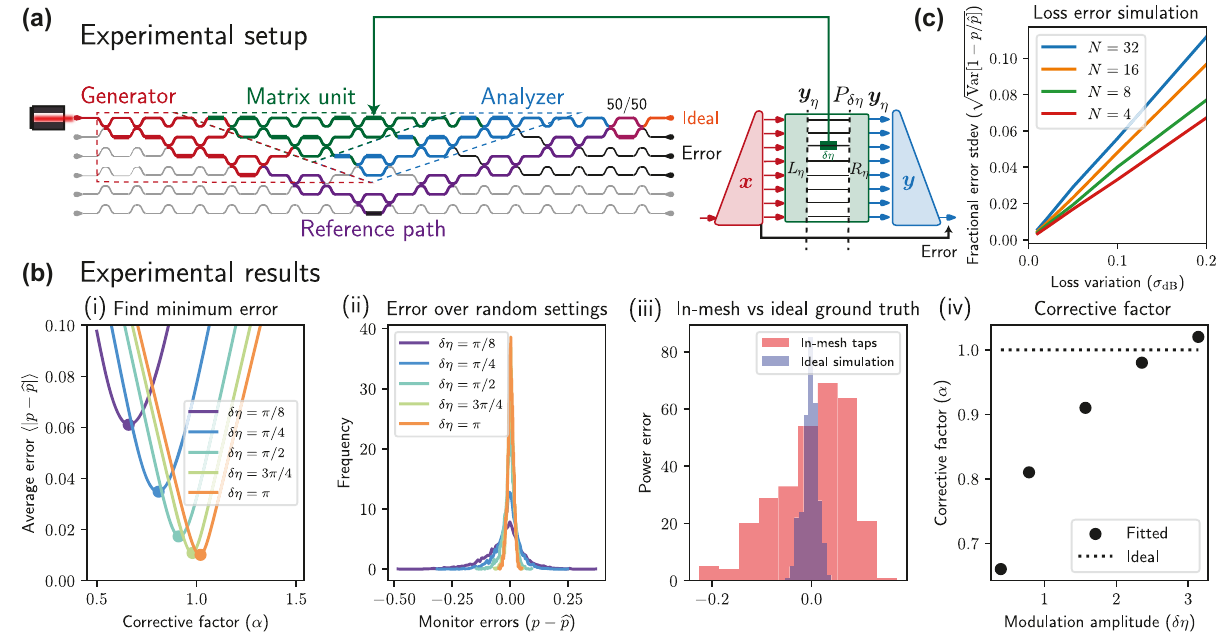
Figure 2: Power monitoring experiment and error scaling: our experiment is run using the setup in Refs. [14, 15]. (a) The experimental setup sends half the light to the “matrix unit” (green) which is the actual photonic mesh, with generator (red) and analyzer (blue) set to the desired input/output behavior. The rest of the light is sent into a reference channel (purple) which interferes at a 50/50 coupler (maroon), allowing for the real part to be measured at the top port (ideal). (b) Over 1000 trials, we monitor powers through six phase shifts given random 3 × 3 unitaries U and inputs x and compare expected p with measured ̂ p for different modulation amplitudes 𝛿𝜂 . (i) We measure an optimized corrective factor 𝛼 , achieving an average error of 0.01 (roughly 3%) for 𝛿𝜂 = 𝜋 . We apply this factor to measure (ii) a histogram of errors over random settings for various 𝛿𝜂 (in radians).